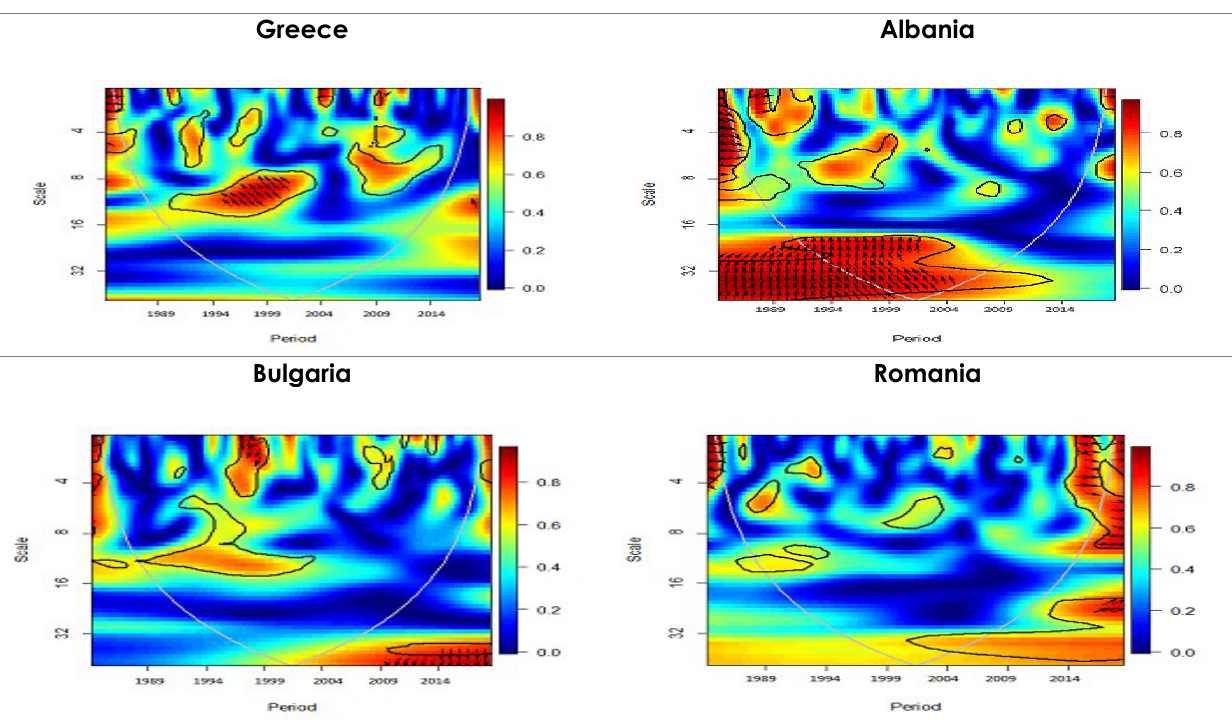
Figure 3. Wavelet Coherence between Political Risk and Financial Risk. Source: Author using Political Risk Group (2019) data.